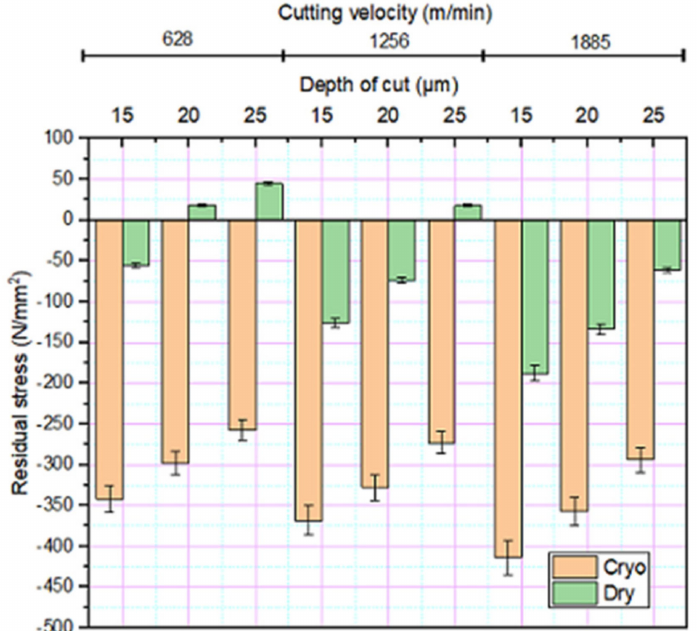
Figure 7. Variation in residual stress under different grinding